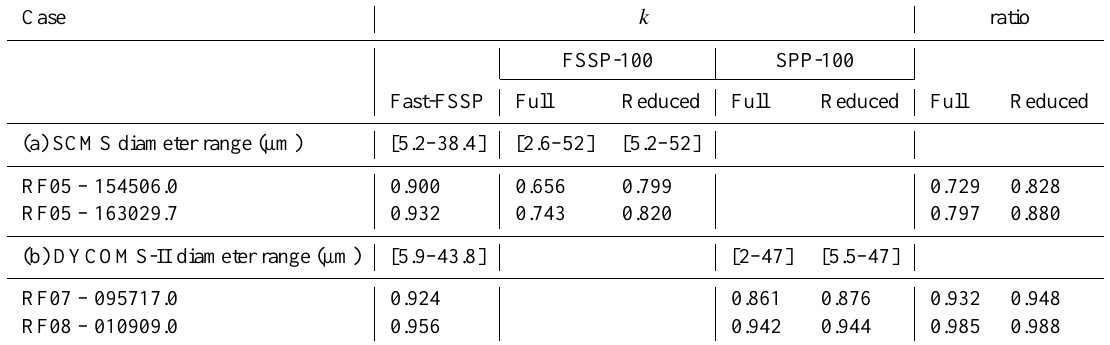
Fig. 1. Droplet size distributions as measured with (a) the FSSP-100 and the Fast-FSSP during SCMS and (b) the SPP-100 and the Fast-FSSP during DYCOMS-II. Table 2. Coefficient k values and ratio of the k coefficient derived from the FSSP-100 or the SPP-100 to the value derived from the Fast-FSSP for the four droplet spectra shown in Fig. 1. Data from the FSSP-100 and the SPP-100 are processed over the full range and after removal of the first classes. The corresponding diameter ranges are indicated for each